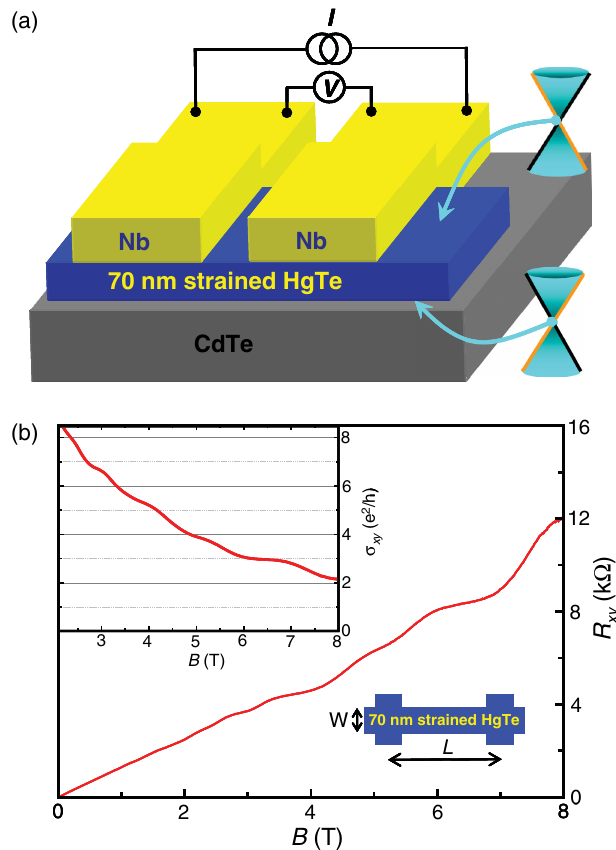
FIG. 1. (a) Schematic picture of a lateral Josephson junction based on a strained, undoped HgTe layer of 70 nm thickness. The Dirac states residing at the surfaces of the HgTe layer form the weak link between the Nb electrodes. Transport measurements on such a junction are performed in current-bias mode while measuring the voltage across the junction to investigate super- conducting transport through the surface states. (b) Transport measurements at T (cid:2) 70 mK on a Hall bar device with L ¼ 600 (cid:3) m and W ¼ 200 (cid:3) m , based on the same HgTe layer as the Josephson junction. The magnetic-field dependence of the Hall resistance R xy shows the development of plateaus, implying transport through two-dimensional states. The inset shows the quantization of the Hall conductivity (cid:4) xy at odd as well as even Landau level filling factors, characteristic of Dirac states at top and bottom surfaces with slightly different densities [4]. This observation demonstrates that the bulk conductance is negligible, and transport is effectively through the topological surface